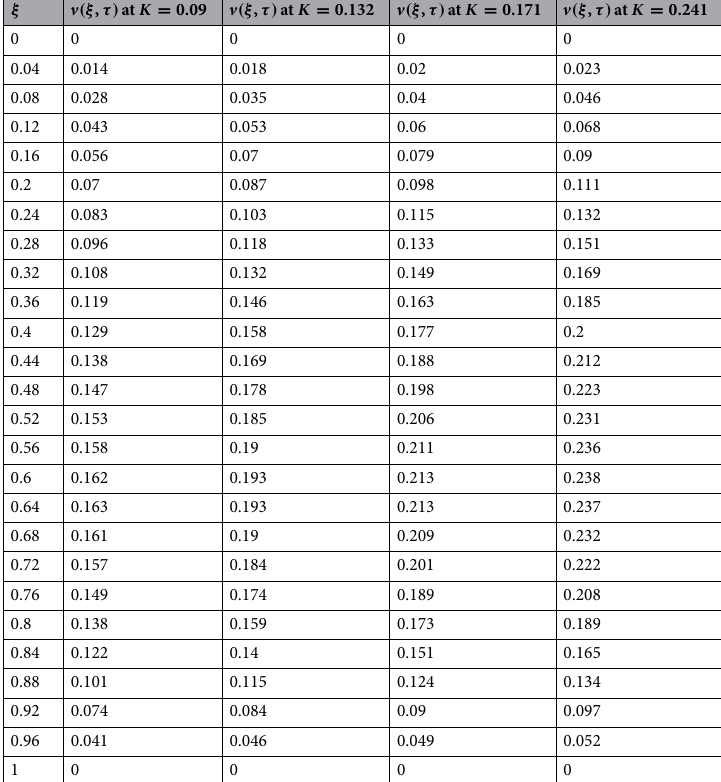
Table 8. Variations in velocity profile against ξ if h (τ) = 0 for different values of K .